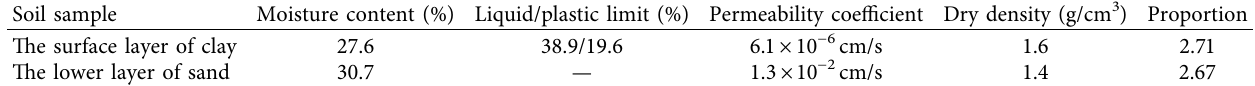
Table 1: Basic physical and mechanical parameters of the test earth materials.